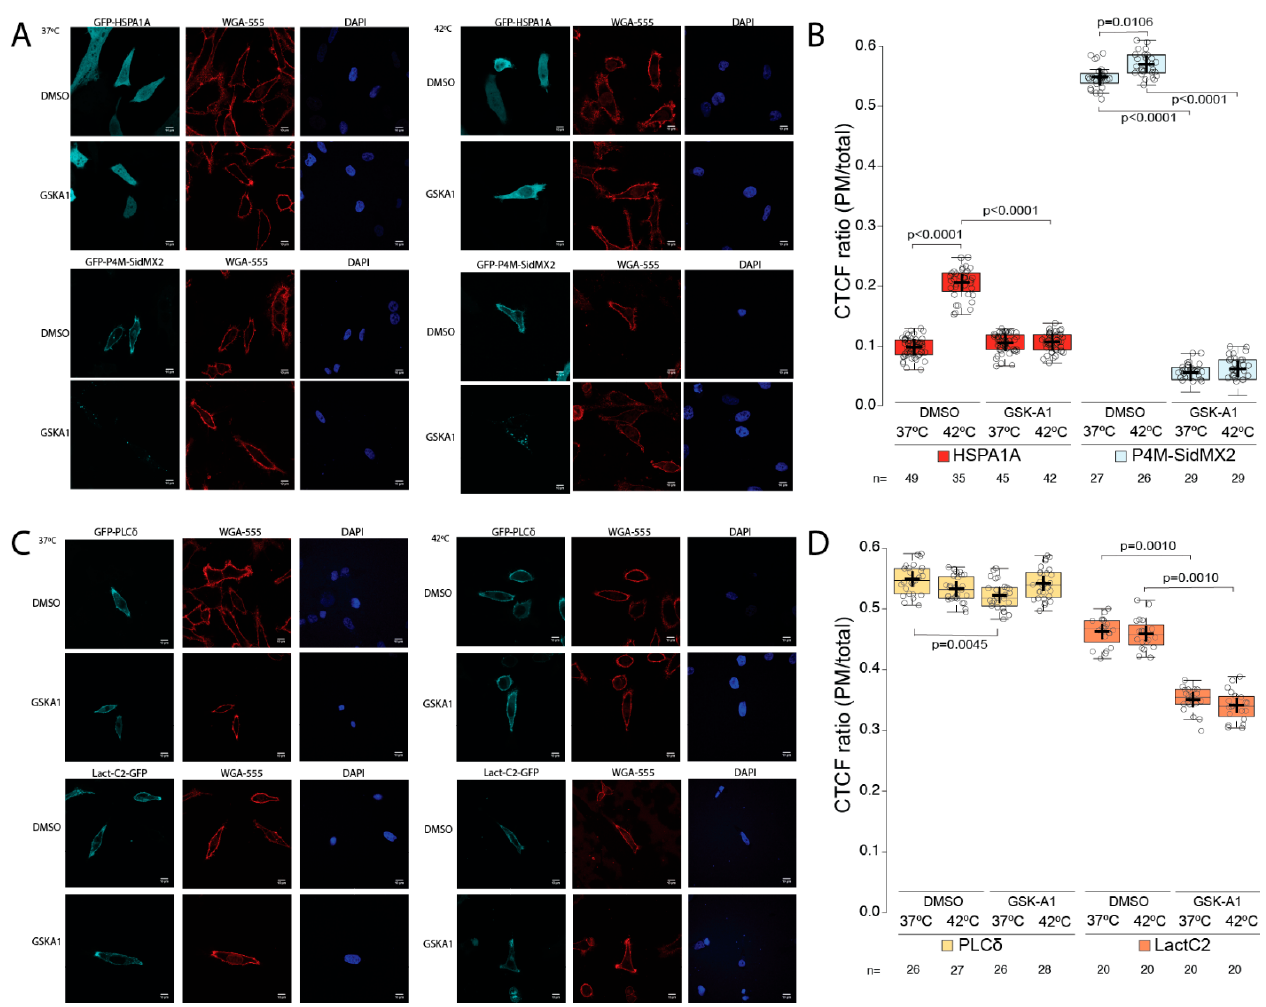
Figure 6. HSPA1A localization at the plasma membrane is significantly reduced by treatment with GSK-A1. Representative images of HeLa cells expressing ( A ) GFP-HSPA1A (top two rows), GFP- P4M-SidMx2 (bottom two rows), ( C ) GFP-PLC δ -PH (top two rows) and Lact-C2-GFP (bottom two rows). In all cases, the PM was stained with WGA-FA555 and the nucleus with DAPI. The PM localization of the proteins was documented at either control conditions (37 ◦ C; left three columns) or heat-shocked conditions (1 h at 42 ◦ C/8 h at 37 ◦ C; right three columns). Negative control cells were treated with DMSO. Scale bar = 10 µ M. ( B , D ) Quantification of the corrected total cell fluorescence (CTCF) as a ratio between the total GFP fluorescence of HSPA1A, P4M-SidMx2, PLC δ -PH, or Lact-C2 at the PM and the rest of the cell at control conditions and after heat shock in the presence of either DMSO (untreated) or GSK-A1. The experiment was repeated three times, and the total number of cells (shown as open circles) per condition are shown at the bottom of the graph. The center lines show the medians; box limits indicate the 25th and 75th percentiles as determined by R software; whiskers extend 1.5 times the interquartile range from the 25th and 75th percentiles; crosses represent sample